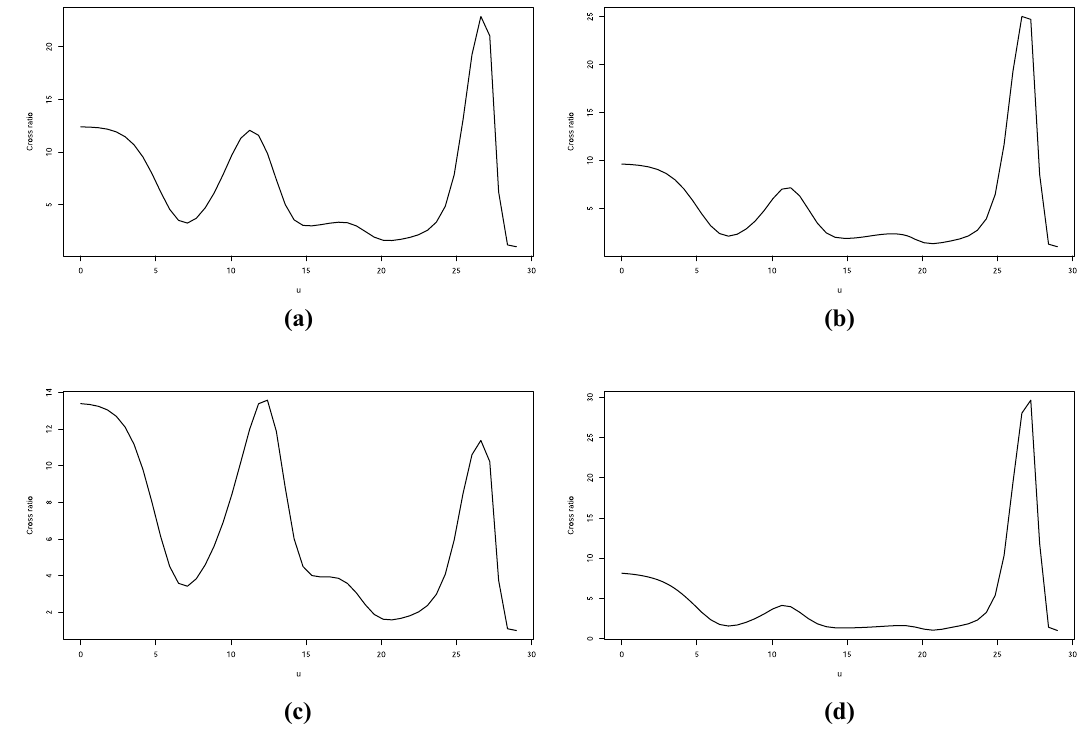
and women ’ s y at issue. ( a ) Man and ( b ) 2 1